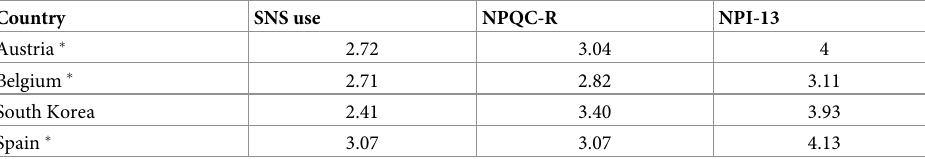
Table 3. Social media use (SNS use) and narcissism (NPQC-R and NPI-13) � . Country